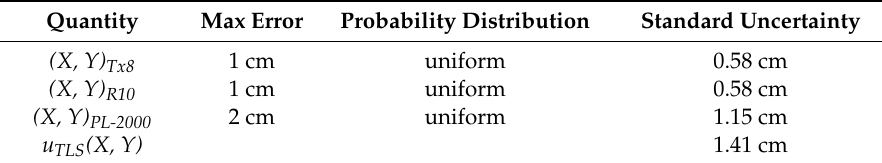
Table 1. Uncertainty budget (X or Y coordinate) of terrestrial laser scanning (TLS) system.